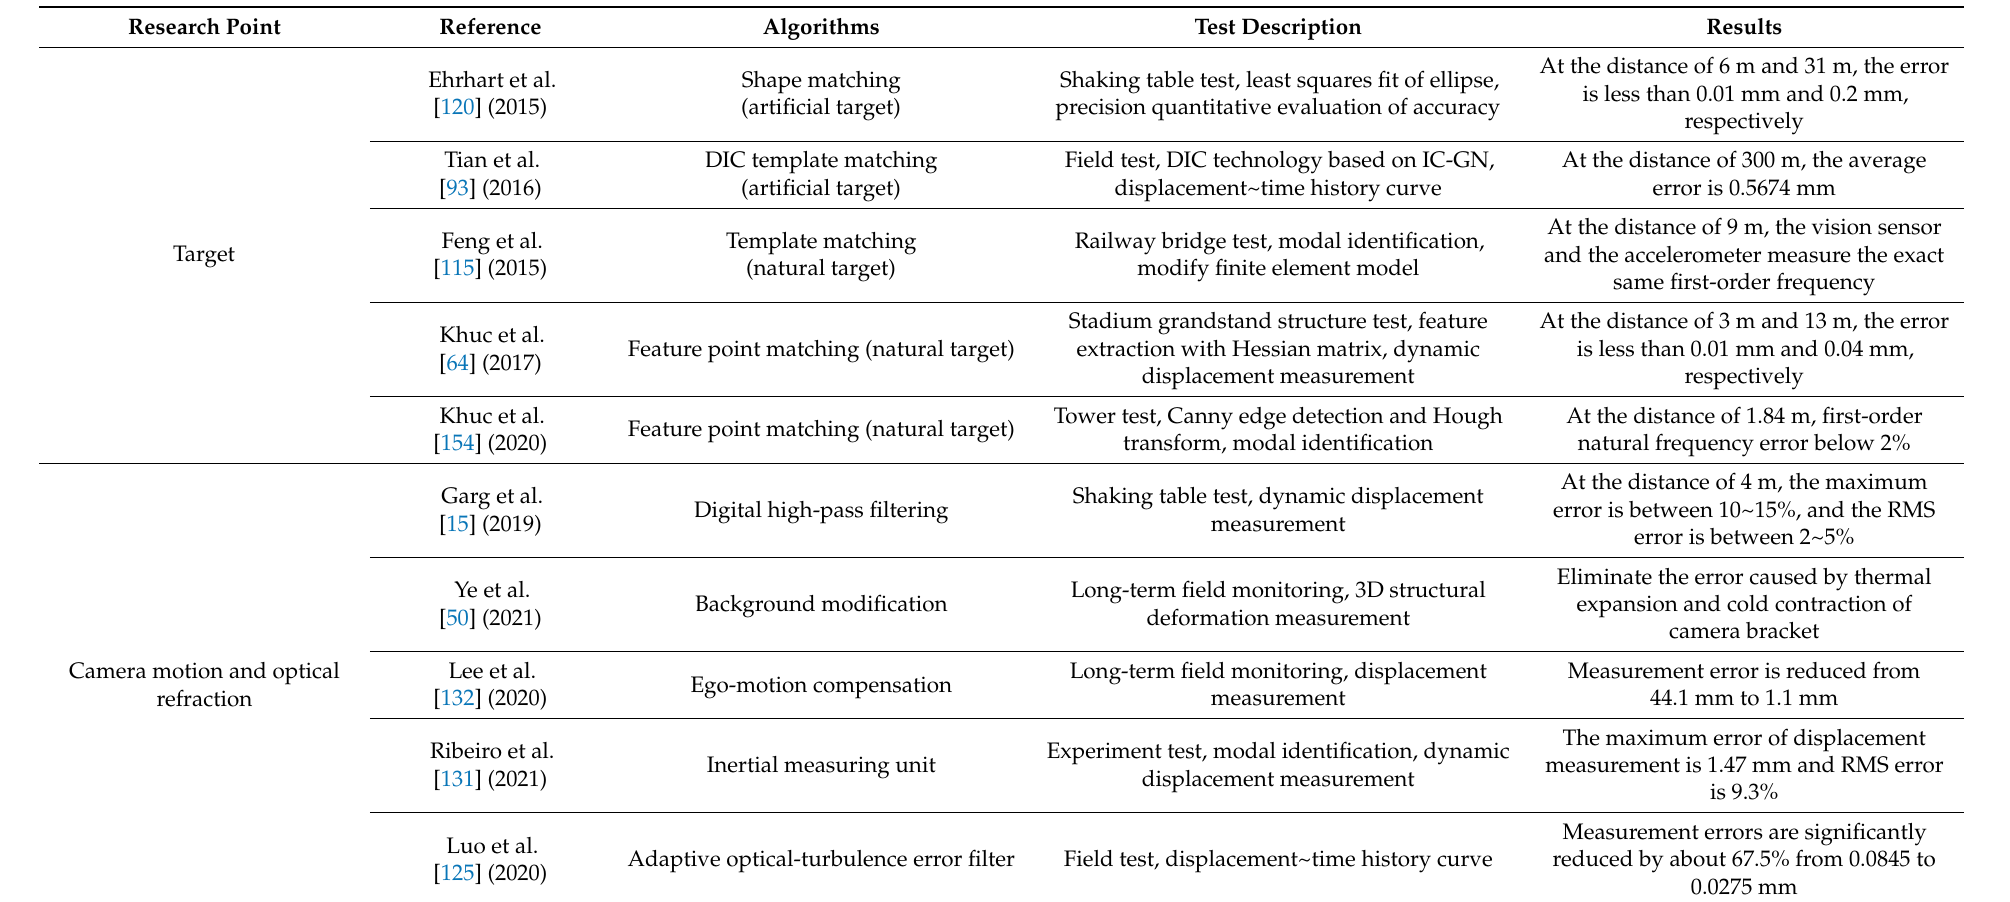
Table 2. Measurement